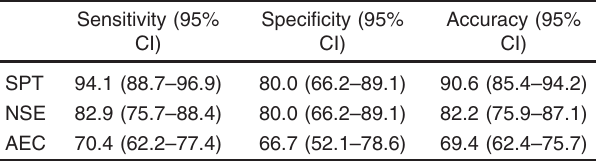
Table 4 A comparison between absolute eosinophil count results among allergic rhinitis and control groups